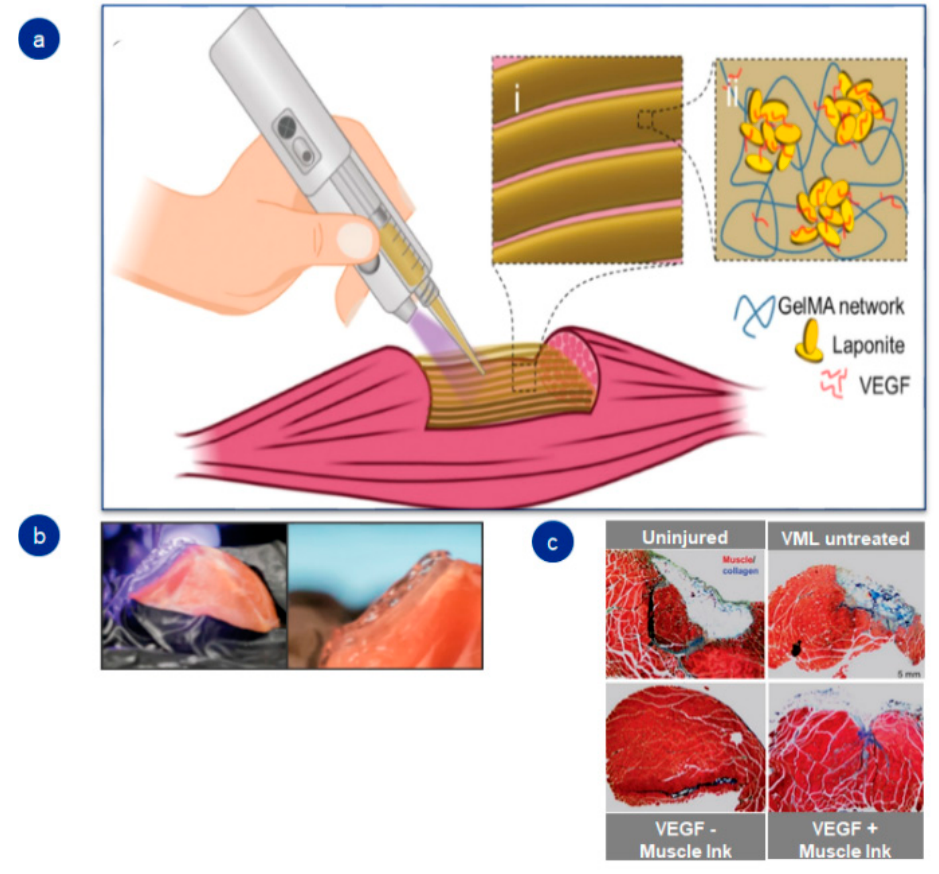
Figure 4. Schematic illustration of 3D portable printer and in vivo outcomes in skeletal muscle: ( a ) graphic diagram; ( b ) images of GelMA-based hydrogel implantation; ( c ) in vivo results of fibrosis in nontreated and treated groups. Adapted with permission from Quint et al. [16]. Advanced